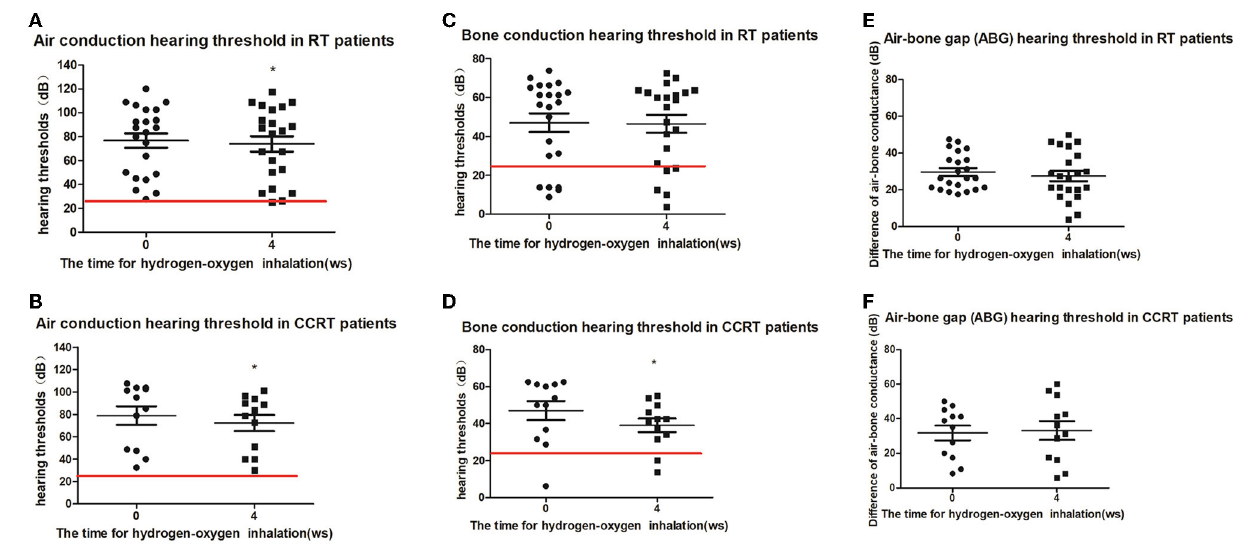
FIGURE 2 | Pure tone hearing threshold tests result before and after hydrogen-oxygen mixed gas inhalation on hearing loss patients with long-term survival after radiotherapy only and concurrent chemoradiotherapy of nasopharyngeal carcinoma. (A) Test results of the air conduction hearing threshold in RT patients. (B) Test results of the air conduction hearing threshold in CCRT patients. (C) Test results of the bone conduction hearing threshold in RT patients. (D) Test results of the bone conduction hearing threshold in CCRT patients. (E) Test results of the air bone gap (ABG) hearing threshold in RT patients. (F) Test results of the air bone gap(ABG) hearing threshold in CCRT patients. The parallel red long lines rep in the figure represent the normal range. Data are analyzed by paired t test. * P < 0.05.